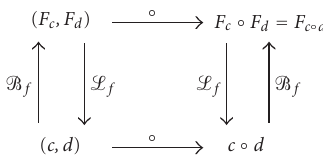
Figure 3.1. The isomorphism between the semigroups ( (cid:4) , ◦ ) and ( R m LC (cid:11)(cid:11) X (cid:12)(cid:12) , ◦ ).